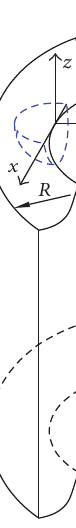
Figure 3: Spherical cavity in the casing inner surface.